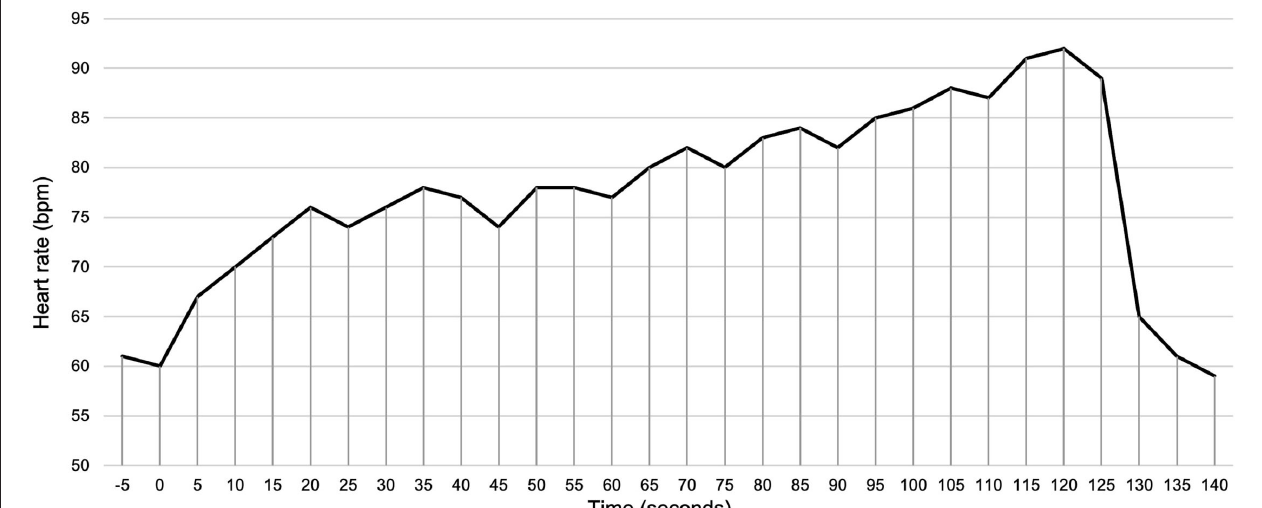
Frontiers in Cardiovascular Medicine |